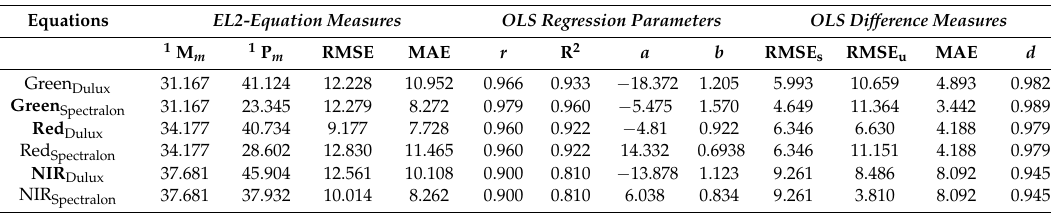
Table 19. Summary statistics of EL2-equations and OLS model